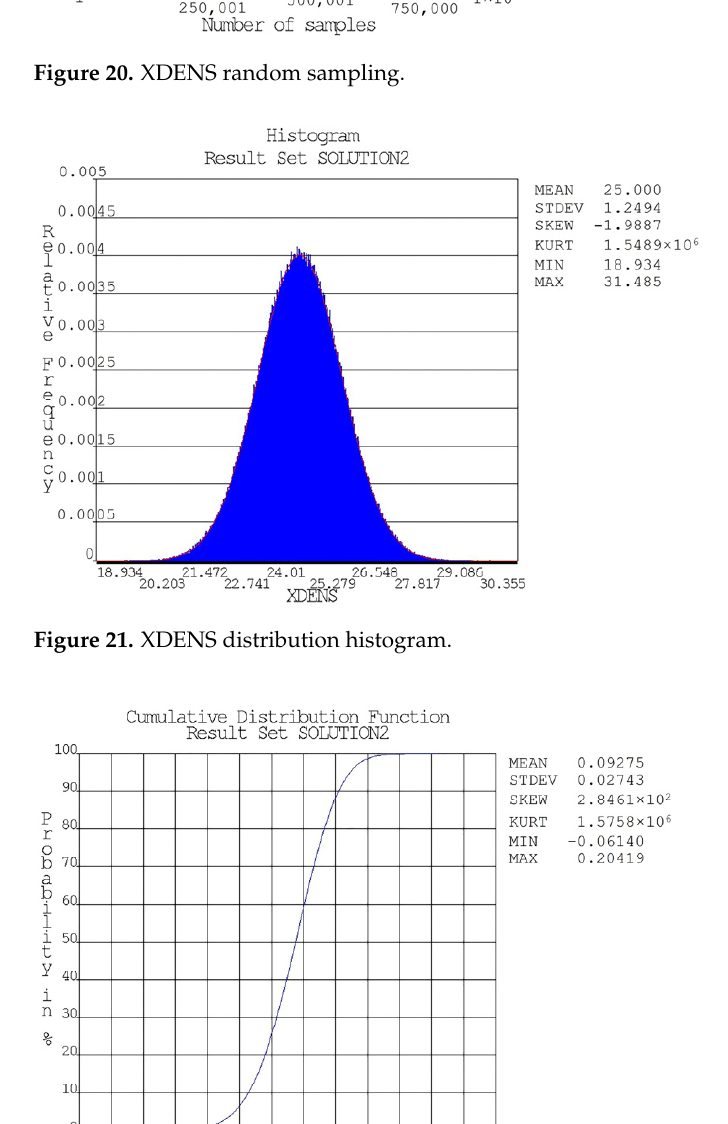
Figure 22. Cumulative distribution curve.